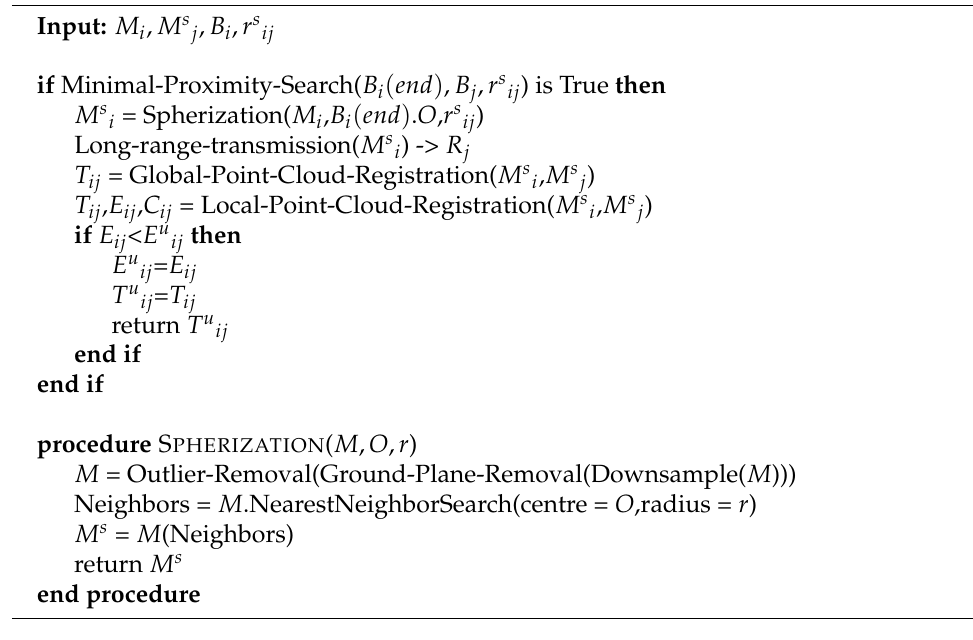
Algorithm 3 Spherized point cloud registration in agent R i